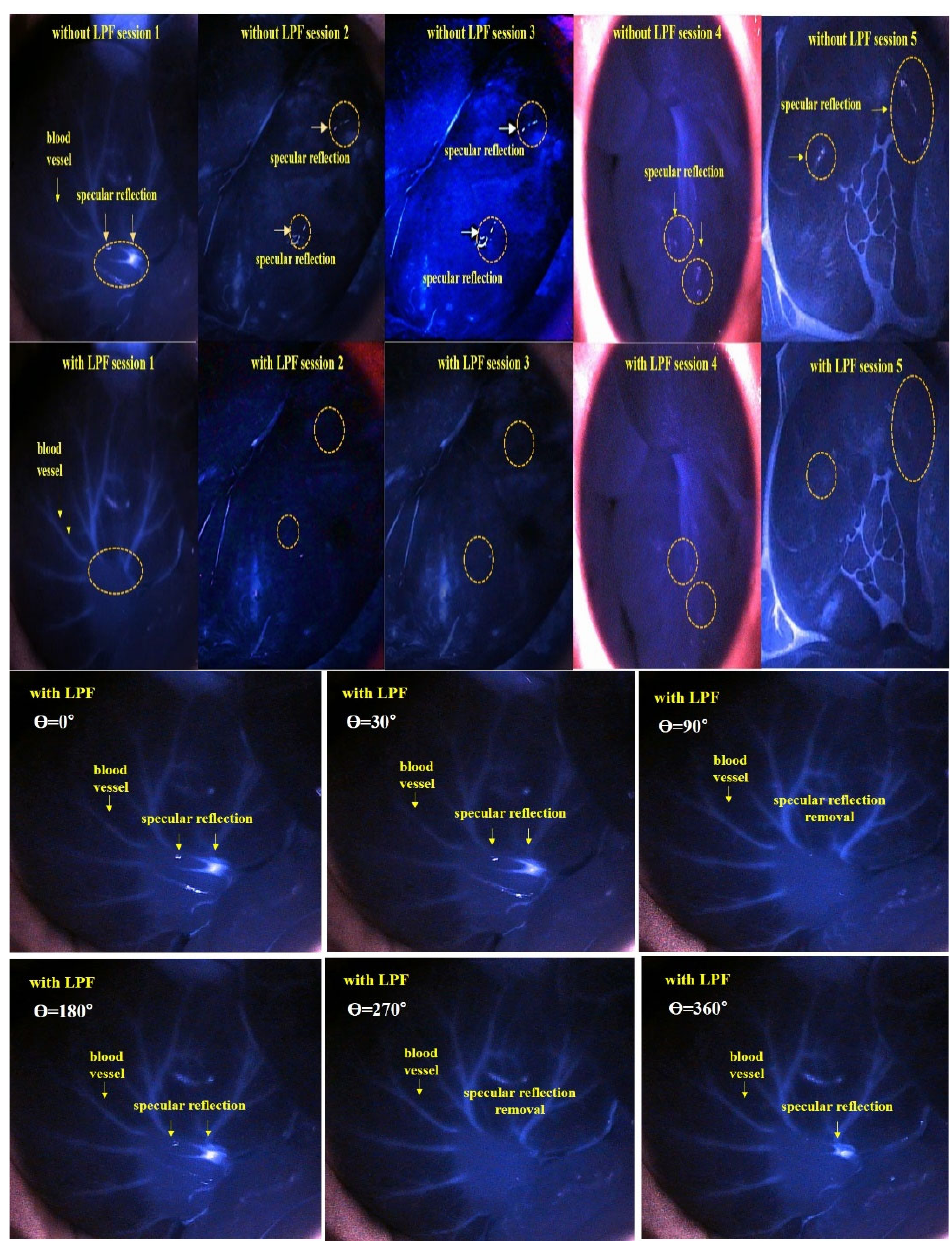
Figure 21. Spectral reflection removal confirmed through small animal experiments. The samples were irradiated with LED mounted on a self-produced hand-held fluo- rescence surgical microscope and image data were collected through an IR camera.